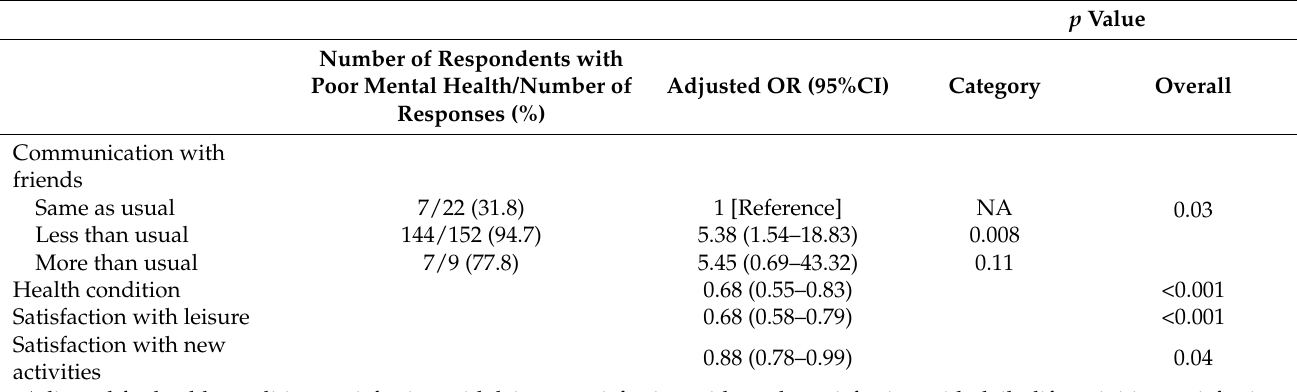
Table 5. Risk factors associated with poor mental health status.